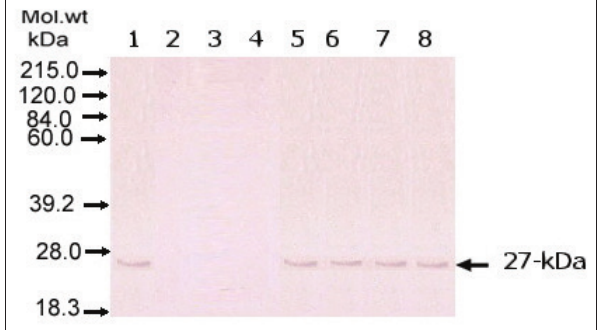
Figure-2: Western blot of serum samples from Fasciola - infected and non-infected cattle to detect circulating Fasciola antigen. Lane 1: Fasciola gigantica worm antigen preparations ( F. gigantica ); lane 2: Serum sample from non-infected cattle; lane 3: Serum sample from cattle infected with Paramphistomum cervi ; lane 4: Serum sample from cattle infected with Strongylids ; lane 5-8: Serum samples from cattle infected with F. gigantica .